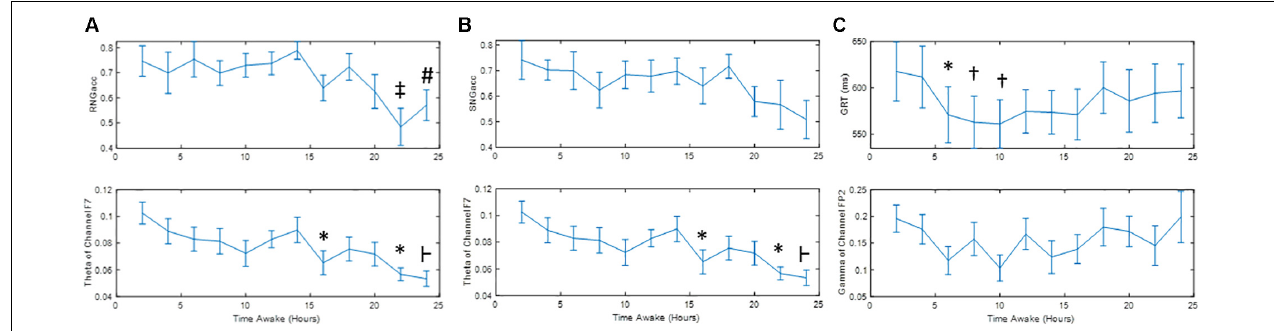
FIGURE 4 | Mean ± Standard Error of (A) RNGacc, (B) SNGacc, and (C) GRT measures and their most-correlated quantitative measure of EEG. Symbols denote significant difference: ∗ to run 1; (cid:96) to runs 1, 2 and 7; ‡ to runs 1, 3, 4, 5, 6, 7, 9; # to run 7; and † to runs 1 and 2.